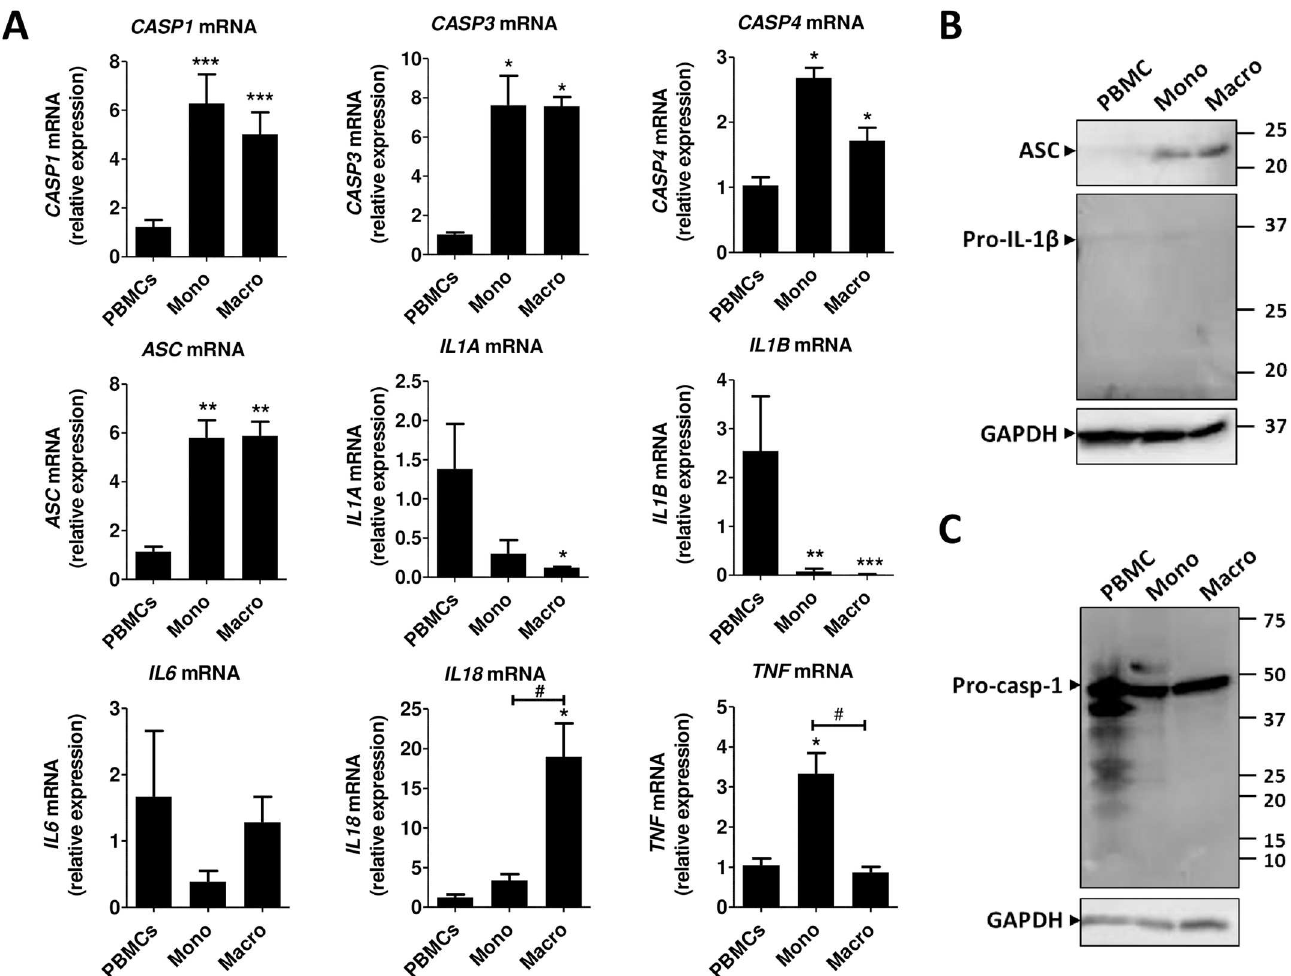
Fig 2. CASP and cytokine expression in human PBMCs, monocytes and macrophages. (A) mRNA gene expressionwas measuredby RT-qPCR and expressedas relativefold change of PBMCs. Data represent the mean ± SEM of (cid:21) 4 experiments performed in duplicatein cells isolated from (cid:21) 4 independentdonors. Asterisks indicate significantdifferences as comparedto PBMCs (Mann Whitney test: * p < 0.05; ** p < 0.01; *** p < 0.001); (#) indicatessignificantdifferences betweenmonocytes and macrophages (Mann Whitney test: # p < 0.05). (B&C) Western blot analysisin total lysates from humanPBMCs, monocytes and macrophages using an anti-ASC, an anti-caspase-1 or an anti-IL-1 β antibody. GAPDH was used as loading control. Western blots are representative of at least 5 independentexperiments. Mono: monocytes; Macro: macrophages; casp-1: caspase-1.